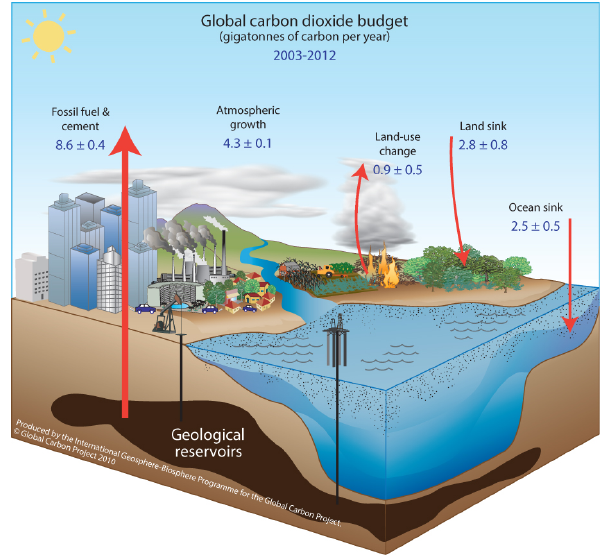
Figure 1. Schematic representation of the overall perturbation of the global carbon cycle caused by anthropogenic activities, av- eraged globally for the decade 2003–2012. The arrows represent emission from fossil-fuel burning and cement production ( E FF ) ; emissions from deforestation and other land-use change ( E LUC ) ; the growth of carbon in the atmosphere ( G ATM ) and the uptake of carbon by the “sinks” in the ocean ( S OCEAN ) and land ( S LAND ) reservoirs. All fluxes are in units of GtCyr − 1 , with uncertainties re- ported as ± 1 σ (68% confidence that the real value lies within the given interval) as described in the text. This figure is an update of one prepared by the International Geosphere Biosphere Programme for the GCP, first presented in Le Quéré